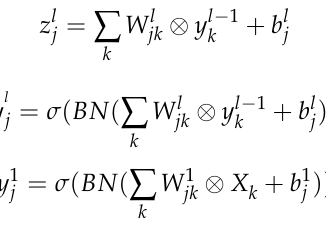
Figure 2. Structural diagram of the ECA attention mechanism. W represents the channel-acquired weights, ( ) σ• the Sigmoid ac- In Formula (1), c C D • the adaptive one-dimensional convolution, and tivation function, 1 ( ) k ture matrix after global average pooling. In Formula (2), k represents the number of local cross-channel interactions, which is the size of the one-dimensional convolutional kernel, C represents the number of channels in the feature matrix, and γ and b represent constants. The experiment is set to 2 and 1, respectively, according to the requirements of the original paper.